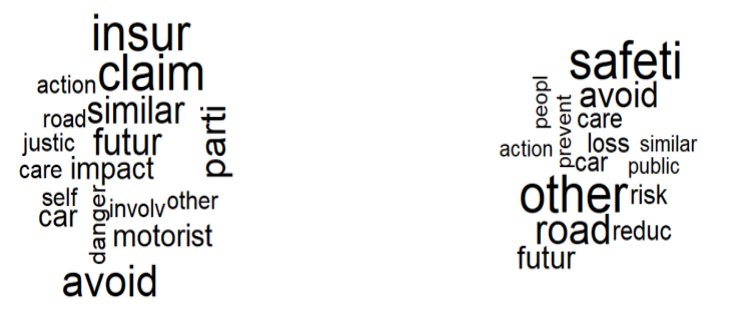
Fig. 2. The word clouds for two topics in